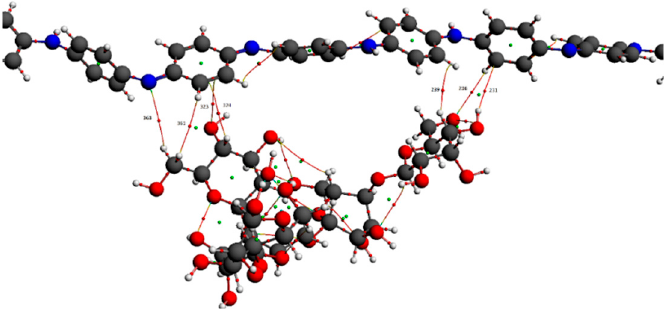
Figure 12. Molecular graph of the optimized PANI–amylopectin complex. Figure 12. σ -profile ( a ) and σ -potential ( b ) distributions of aniline, polyaniline, and amylopectin. Table 13. The topological characteristics at BCP of interaction contacts. Table 13. The topological characteristics at BCP of interaction